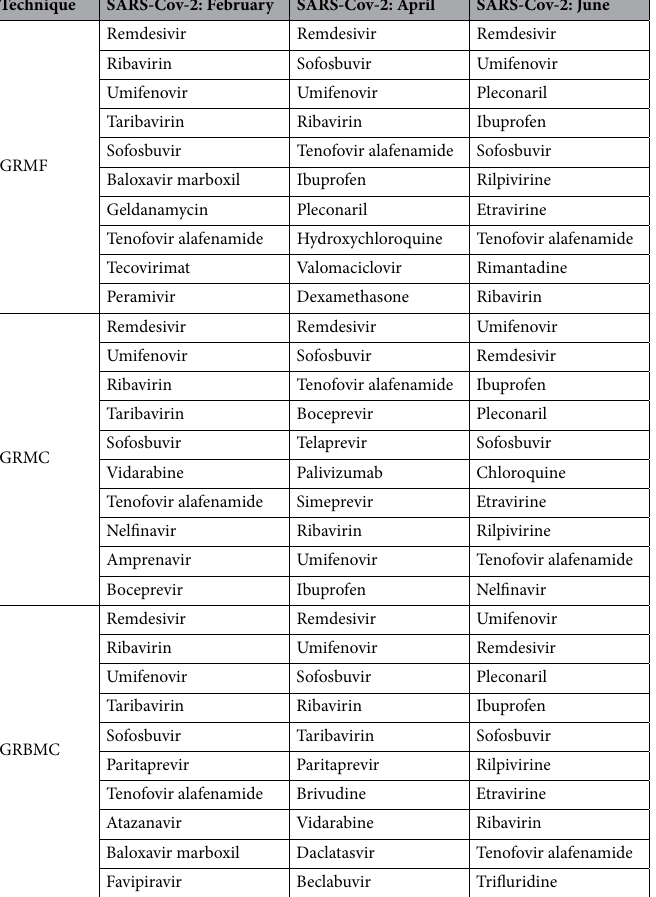
Table 4. Top-10 drugs predicted for three isolates of SARS-Cov-2 (collected at an interval of 2 months) by the DVA computational methods.